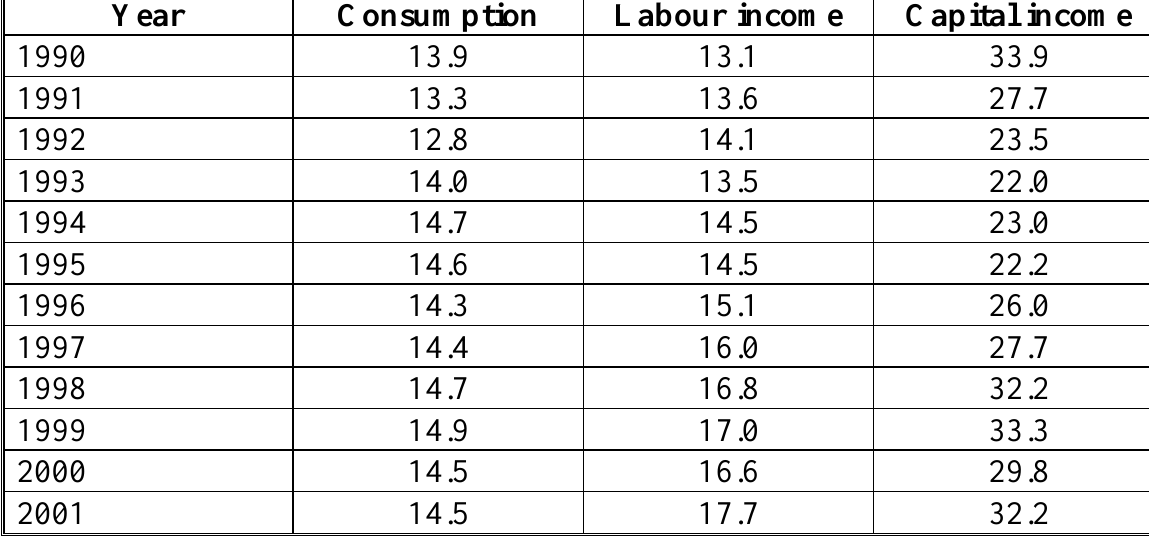
Effective tax rates for consumption, labour income and